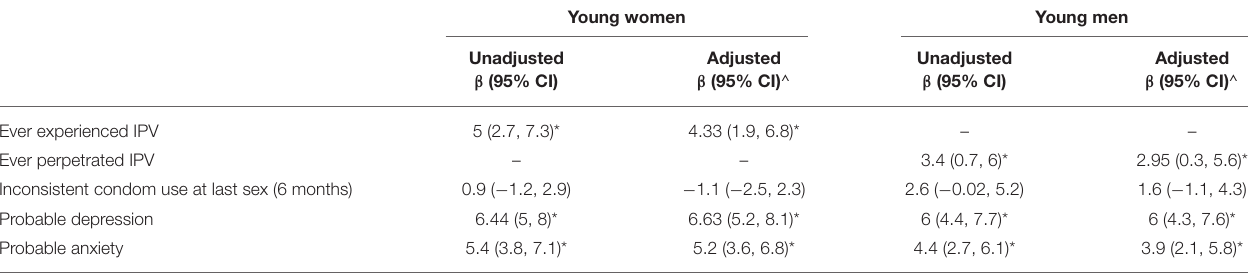
TABLE 3 | Factors associated with higher PSS 10 scores among study participants ( n =